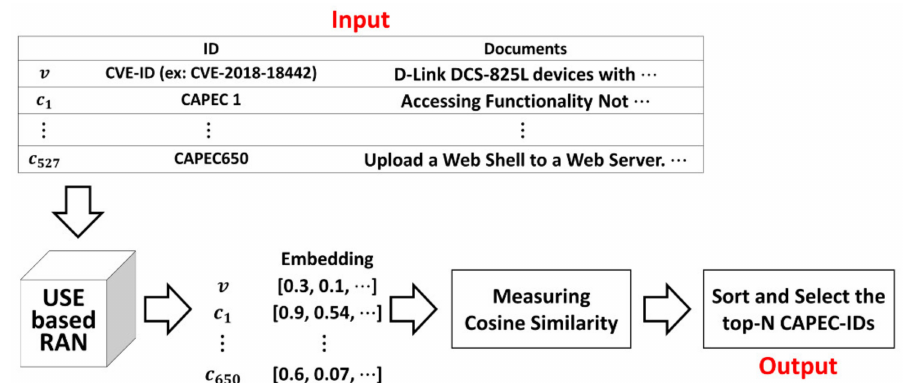
Figure 3. Overview of the tracing method based on Universal Sentence Encoder.